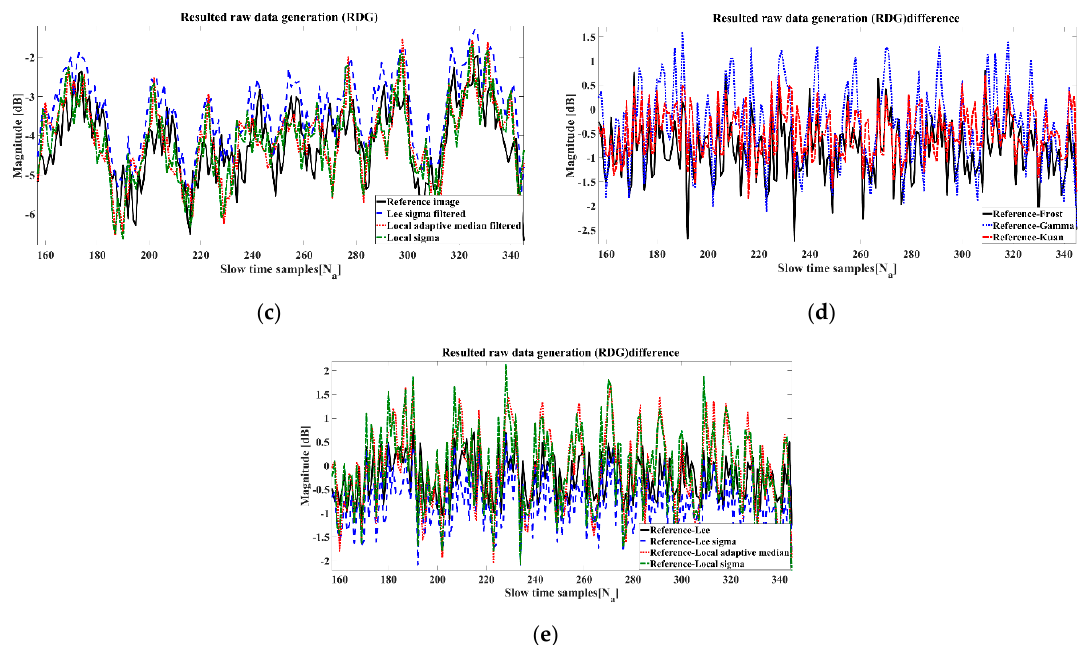
Figure 8. Resulting RDG presentation ( a ) Reference, Frost and Gamma ( b ) Kuan, Lee ( c ) Lee sigma, Local adaptive median and Local sigma—resulting RDG differences ( d ) Frost, Gamma and Kuan ( e ) Lee, Lee sigma, Local adaptive median and Local sigma—RDG evaluation.